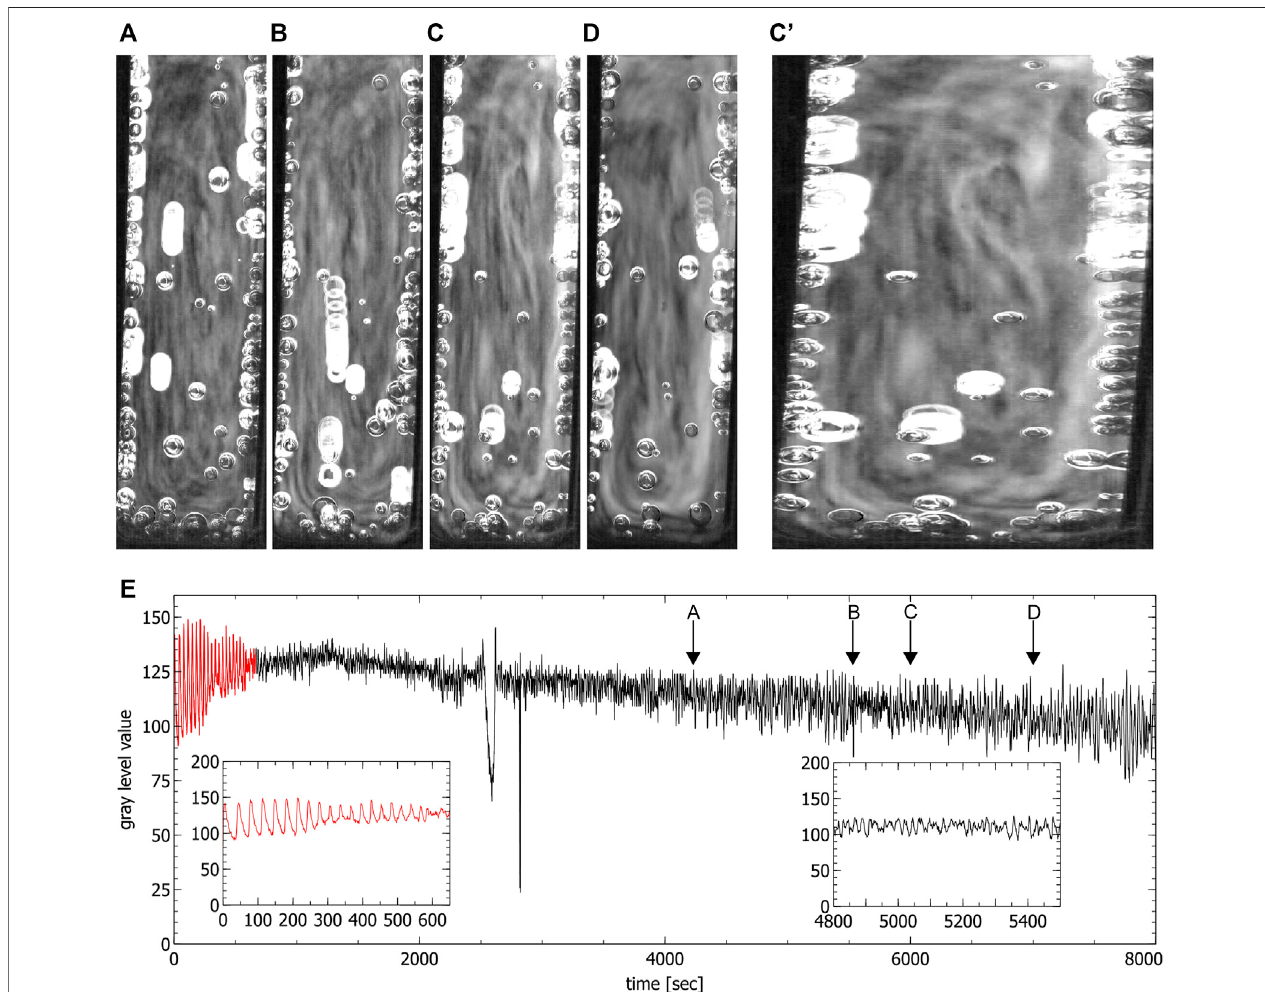
FIGURE5| Convectioncellsinafully fi lledstandardcuvetteduringthechaoticphase. (A – D) showtheupanddownmotioninsidetheliquid.Imageswereobtained by averaging over 60 s (C ’ ) shows sub fi gure (C) stretched for better visibility, (E) is the time series extracted from the video data where the red part corresponds to the periodic phase. Insets show the periodic phase (left) and part of the chaotic phase (right) magni fi ed (spikes in the time series correspond to the passage of bubbles). Arrows indicate the times where the images (A – D) were created.